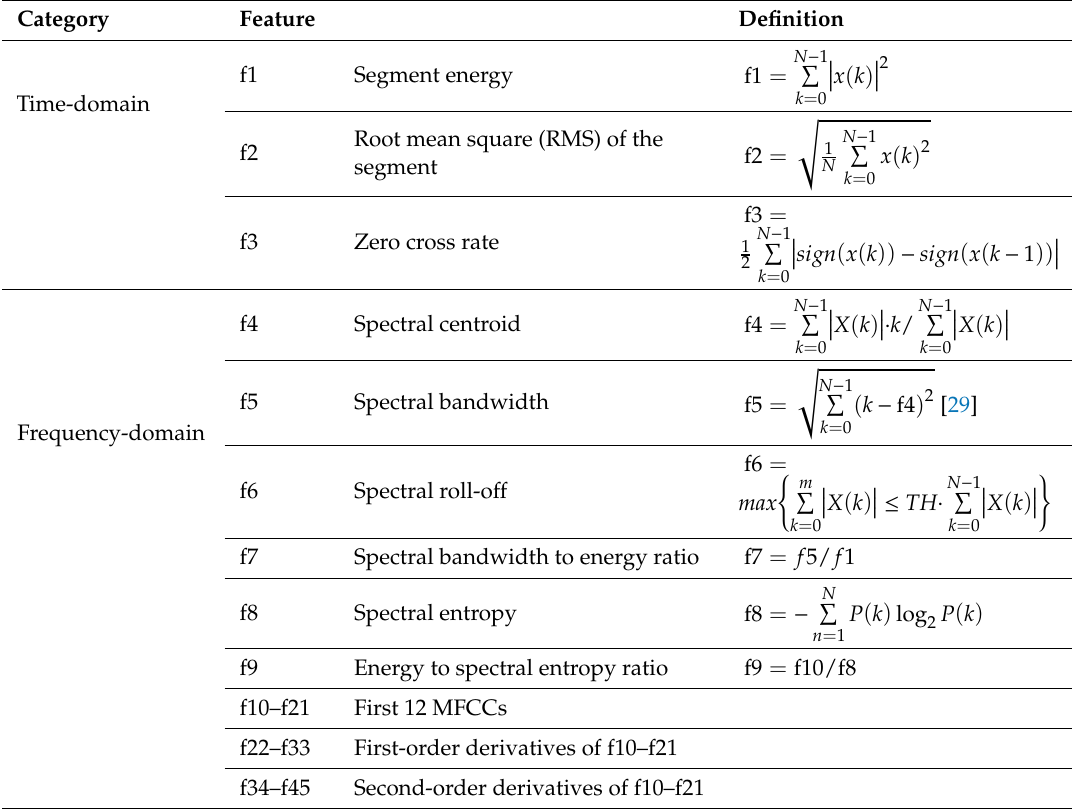
Table 1. Features used in this